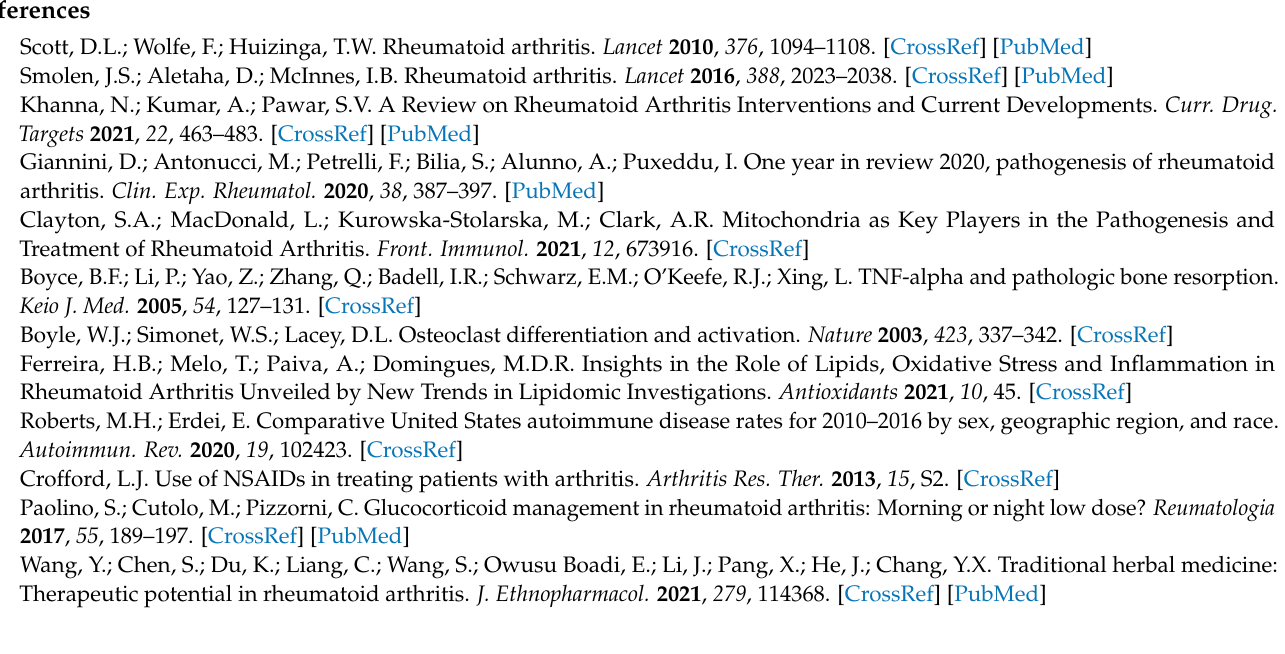
potential targets. Figure S1: The related targets of purpurin in rheumatoid arthritis pathway. Supple- mentary method regarding the basis of dose usage in animal